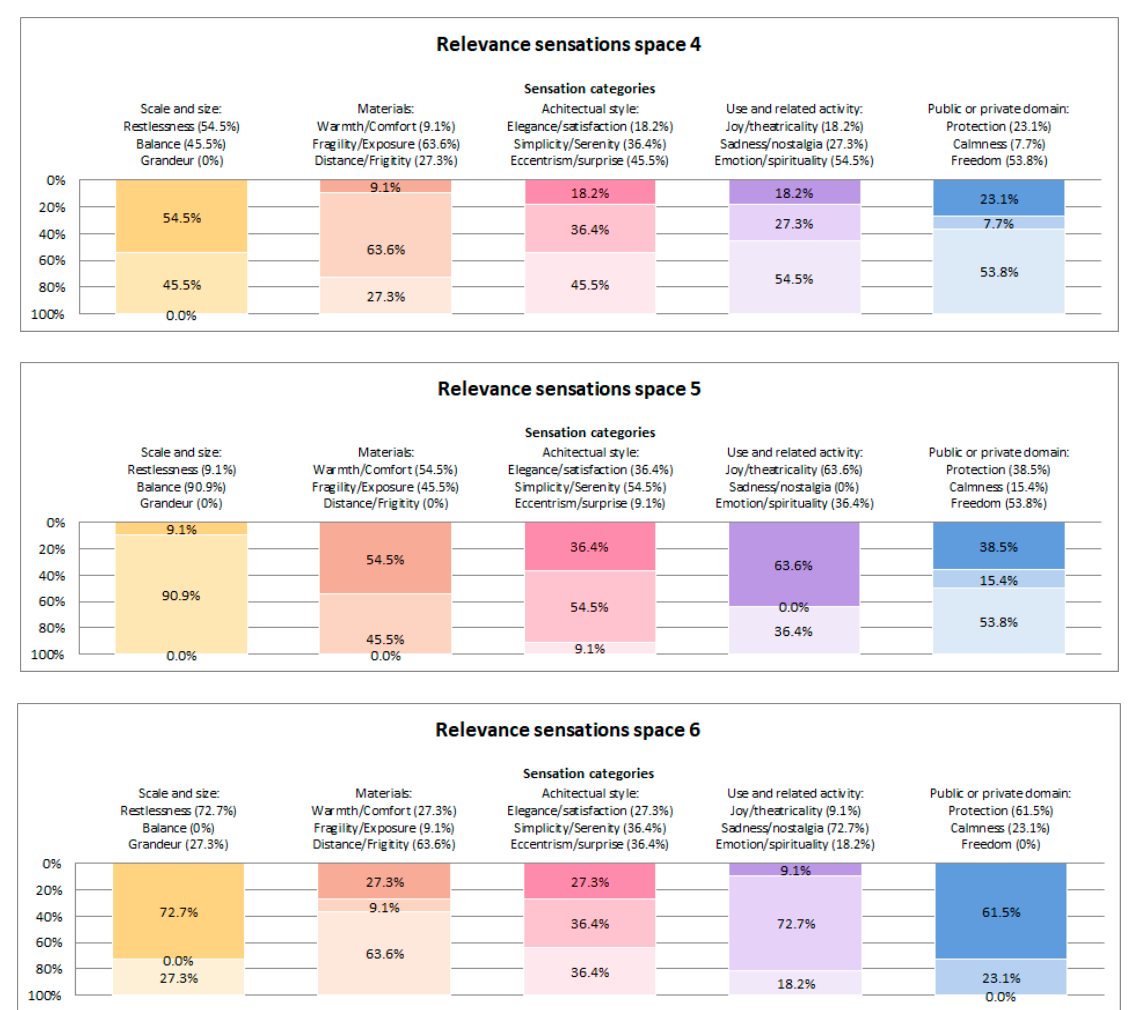
Figure 13. Sensations perceived by the participants in each of the spaces. Table 6. Proposed and predominant sensations.